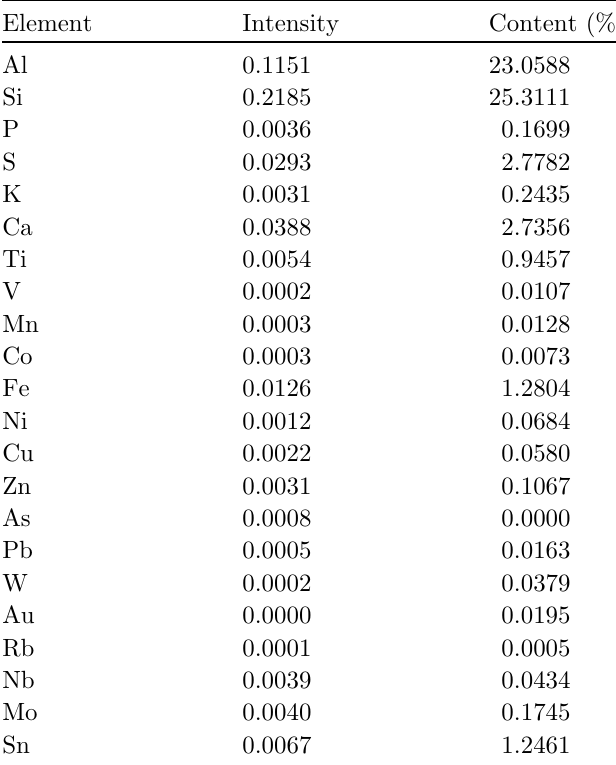
Table 2. XRF result for PU foam with kaolin.